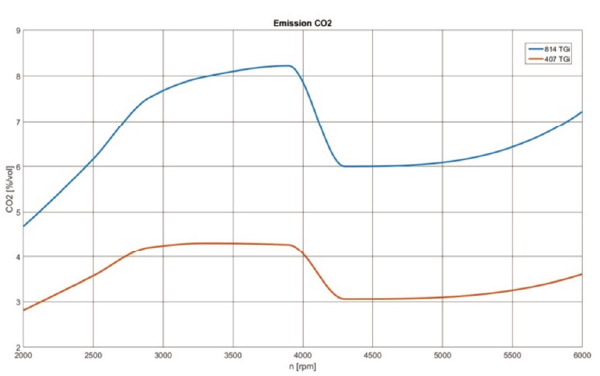
Fig. 9. The CO 2 emission profile for internal combustion engines in the function of rotational speed